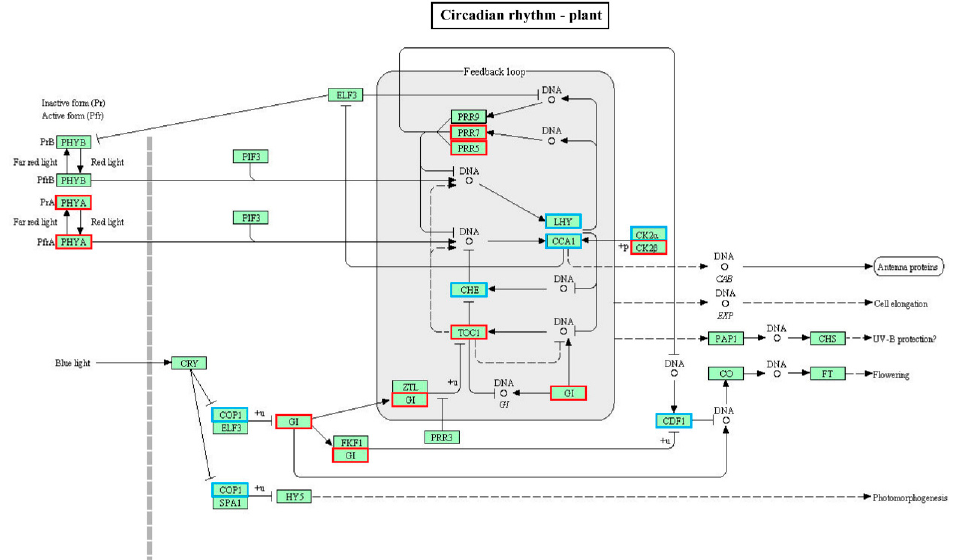
Figure 6. The “circadian rhythm-plant” pathway enriched by KEGG analysis of DE mRNA corresponding genes in the cultivar “Huoche” under heat stress. KEGG orthology (KO) nodes containing up-regulated genes are marked with red boxes, while KO nodes containing down-regulated genes are marked with blue boxes. PHYA, phytochrome A; COP1, E3 ubiquitin-protein ligase RFWD2; GI, gigantea; PRR7, pseudo-response regulator 7; PRR5, pseudo-response regulator 5; CHE, transcription factor TCP21 (protein CCA1 HIKING EXPEDITION); TOC1, pseudo-response regulator 1; LHY, MYB-related transcription factor LHY; CCA1, circadian clock associated 1; CK2 α , casein kinase II subunit alpha; CK2 β , casein kinase II subunit beta; CDF1, Dof zinc finger protein